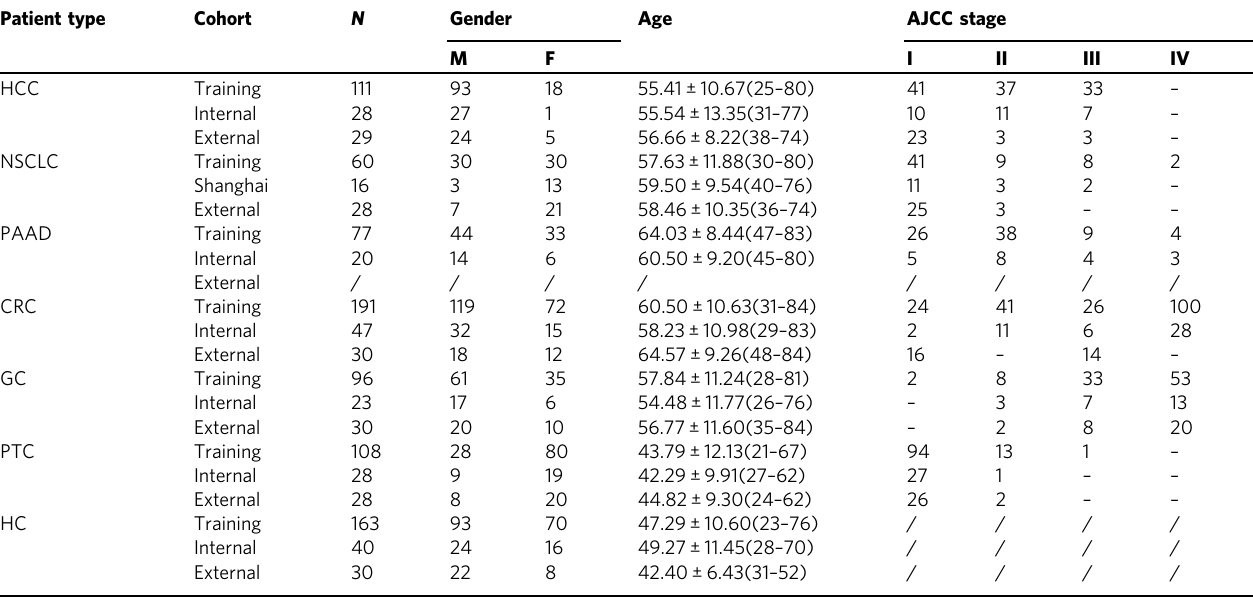
Table 1 Summary of patient and healthy control clinical